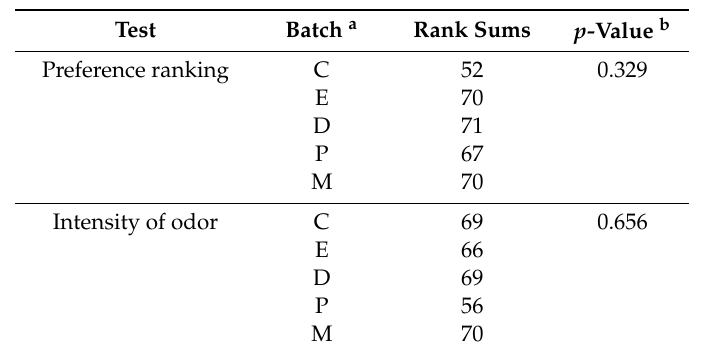
Table 3. Rank sums scores for preference ranking and the odor intensity scale of dry-cured fermented sausages (salchich ó n) inoculated with the biocontrol agents after 21 days of ripening. p- values from Friedman’s chi-square test are also